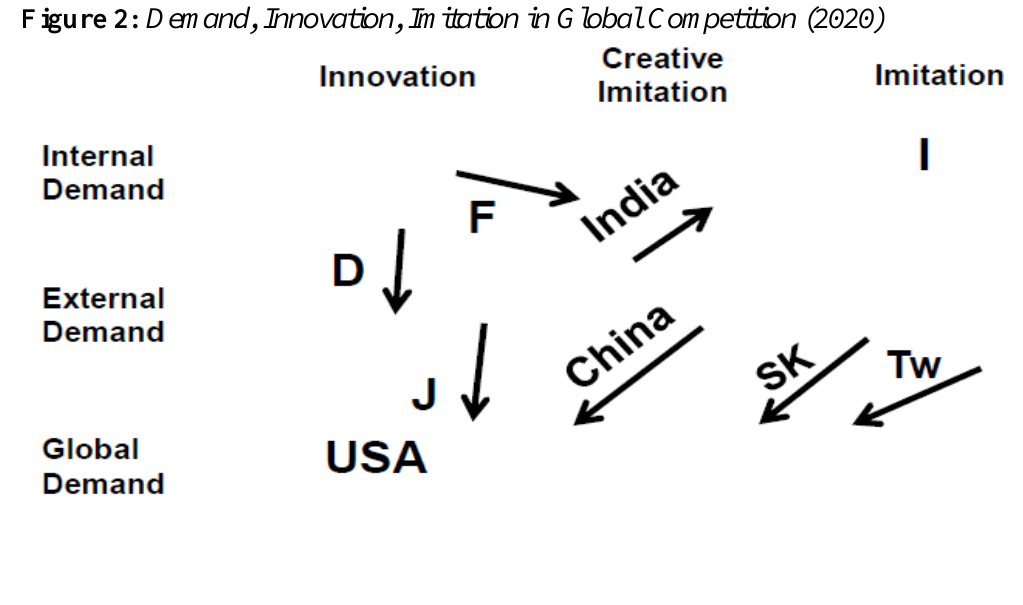
Figure 2: Demand, Innovation, Imitation in Global Competition